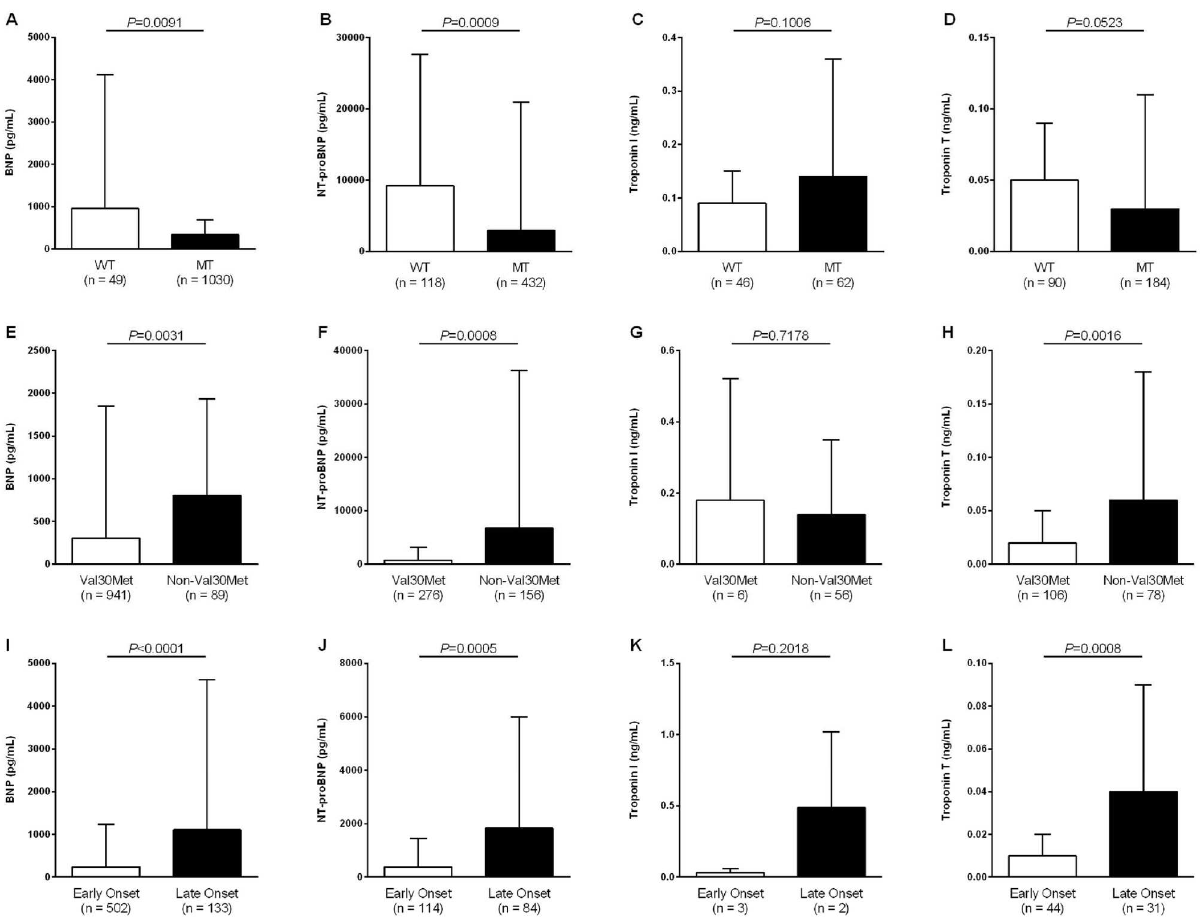
Fig 1. Unadjusted comparison of cardiac biomarkers in patients with ATTR by genotype, mutation, and age at disease onset. (A) BNP in patients with wild type (WT) vs. mutant type (MT); (B) NT-proBNP in patients with WT vs. MT; (C) TroponinI in patients with WT vs. MT; (D) TroponinT in patients with WT vs. MT; (E) BNP in patients with Val30Met vs. non-Val30Met mutations; (F) NT-proBNP in patients with Val30Met vs. non-Val30Met mutations; (G) TroponinI in patients with Val30Met vs. non-Val30Met mutations; (H) Troponin T in patients with Val30Met vs. non-Val30Met mutations; (I) BNP in patients with early vs. late onset of ATTR due to Val30Met mutation; (J) NT-proBNP in patients with early vs. late onset of ATTR due to Val30Met mutation; (K) Troponin I in patients with early vs. late onset of ATTR due to Val30Met mutation; (L) TroponinT in patients with early vs. late onset of ATTR due to Val30Met